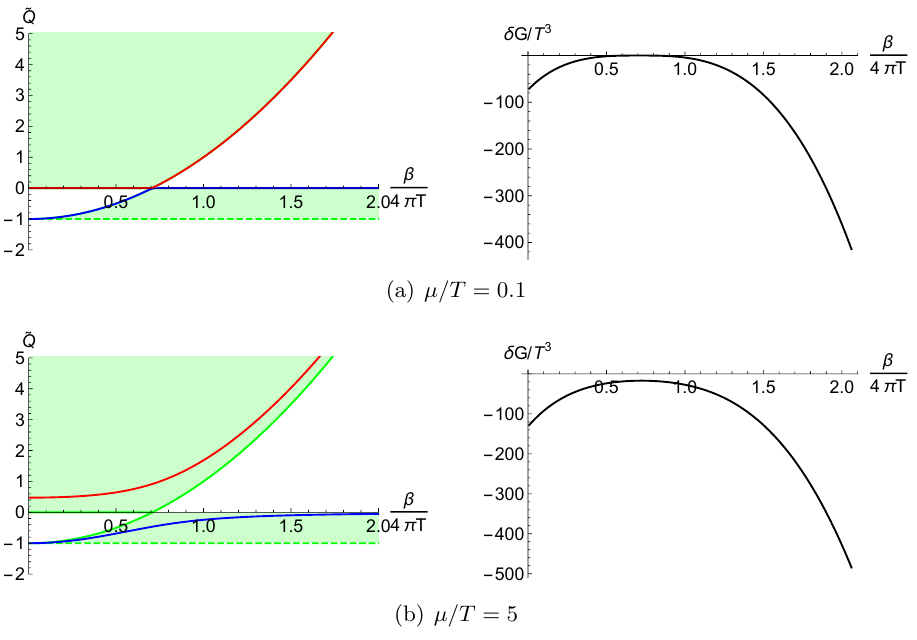
Figure 3 . The left panel: two values of ~ Q for given (cid:22)=T = 0 : 1(a) and (cid:22)=T = 5(b). The red curve is for positive ~ Q and the blue curve is for negative ~ Q . The right panel: the di(cid:11)erence of the grand potential ( (cid:14)G = G ( ~ Q > 0) (cid:0) G ( ~ Q < 0) is shown. The positive ~ Q solution is always thermodynamically preferred. The green region represent two branches in